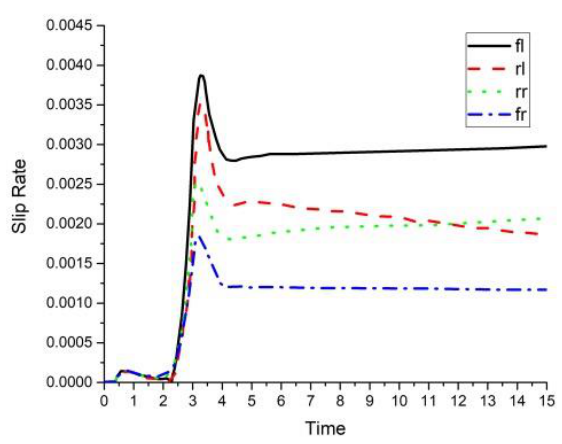
Figure 18. Slip Figure 18. Slip rate. Figure 18. Slip rate.